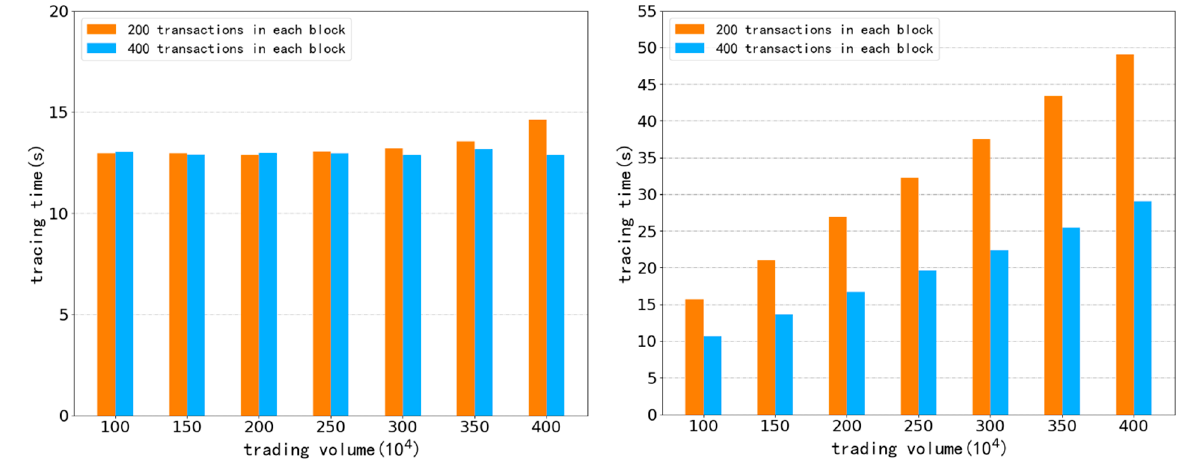
( b ) Comparison of different packing sizes on traceability efficiency in traditional on-chain tracing. Figure 7. The influence of packaged transaction volume in each block on traceability efficiency.